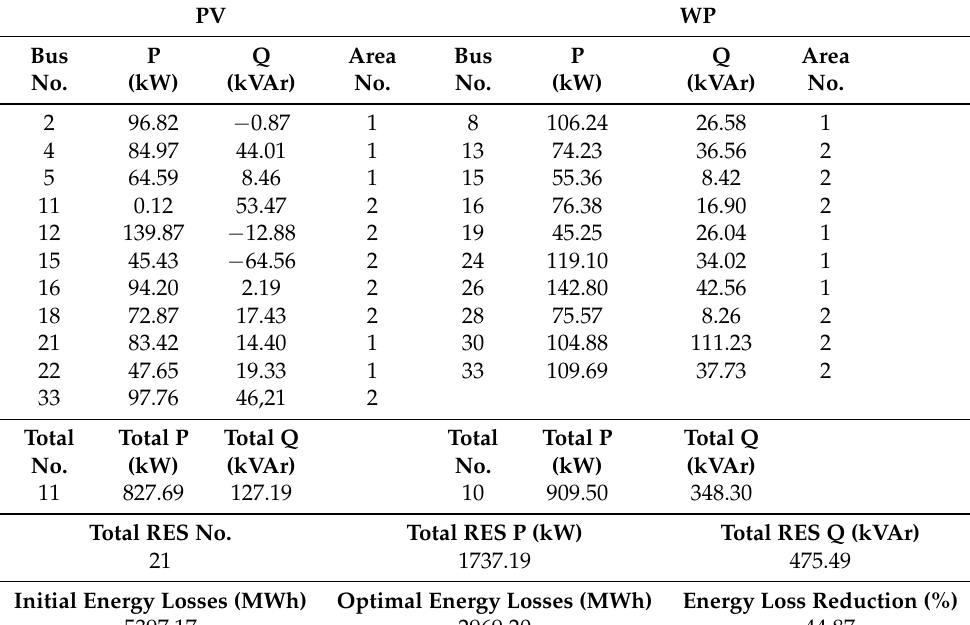
Table 20. Snapshot approach—mean value—Scenario